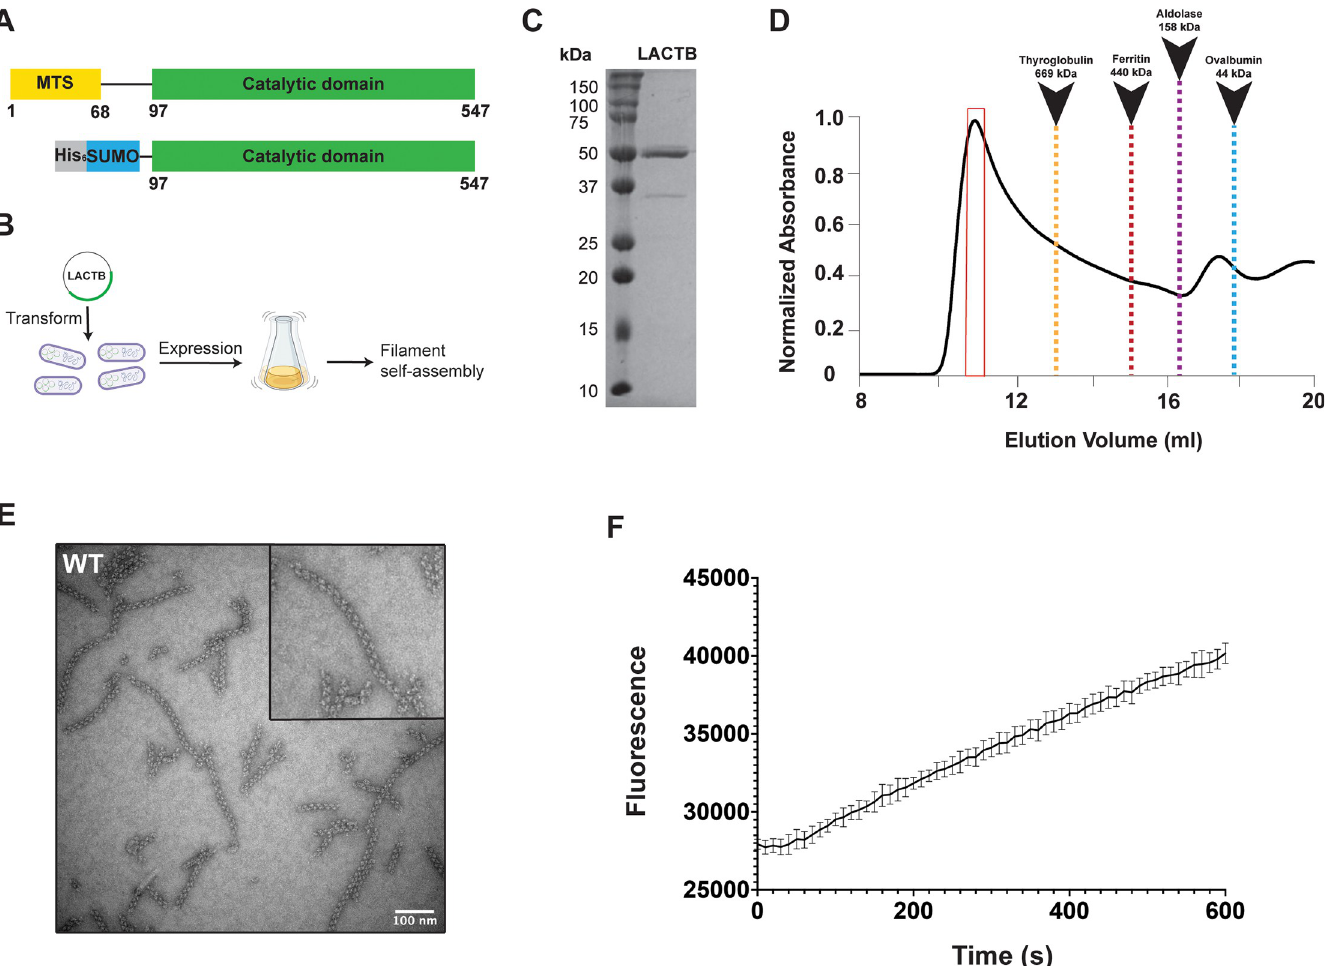
Fig 1. Human LACTB assembles into a filament. ( A ) Domain organization of full-length human LACTB and the construct used in the study. The color scheme is used throughout the manuscript. ( B ) Schematic diagram for recombinant expression and self-assembly of LACTB. ( C ) Coomassie-stained SDS-PAGE of purified LACTB filament. ( D ) Size-exclusion profile of WT LACTB using a Superose 6 column. SEC elution profile begins with the void volume (V 0 ) of the column. ( E ) Representative negative-stain TEM image of purified samples containing high molecular weight species. Negative-stain TEM analysis is shown for the samples taken from the primary peak observed in the size-exclusion chromatogram and is highlighted with a red box in ( C ). Scale bar, 100 nm. ( F ) Activity of the purified LACTB filaments was determined by using a fluorescence-based assay with the error bars representing the SEM. Source data for ( F ) is provided in sheet Fig 1F in S1 Data. SEC, size-exclusion chromatography; SEM, standard error of the mean; TEM, transmission electron microscopy; WT, wild-type.